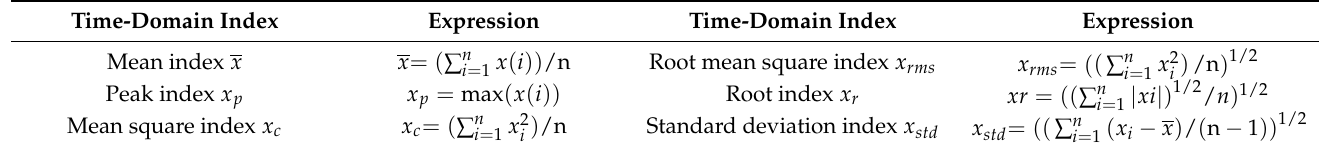
Table 1. Dimensioned time-domain index.